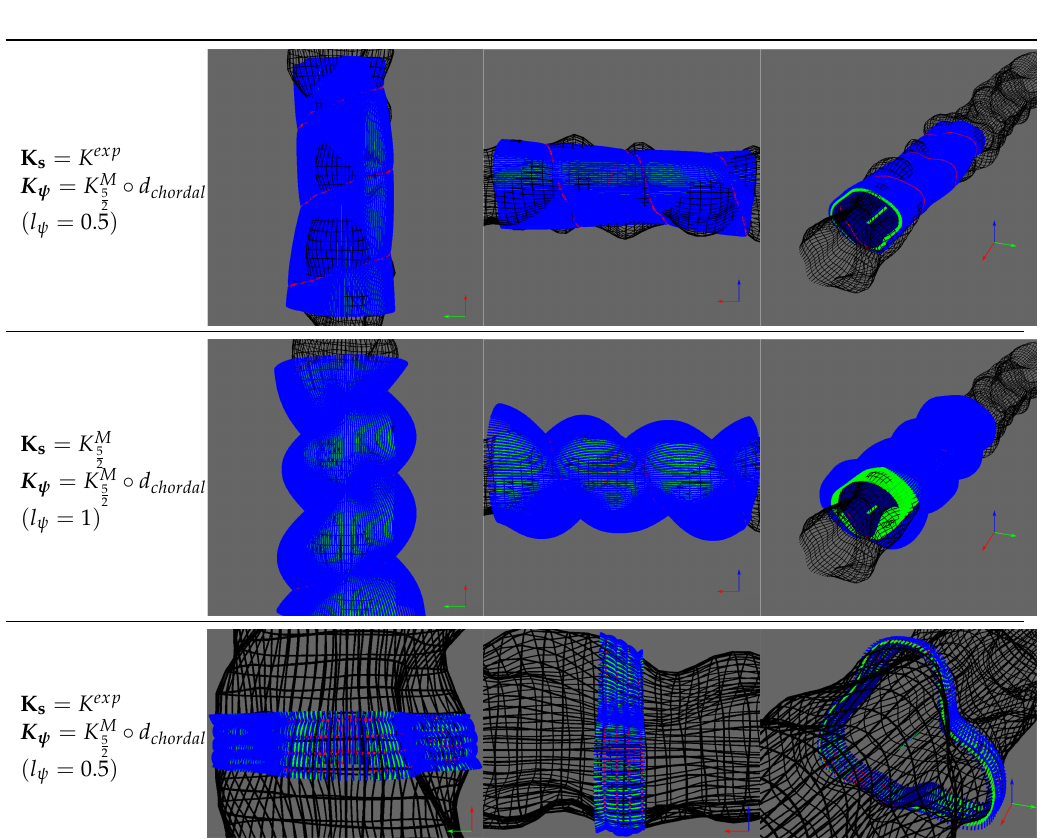
Figure 12. Some 3D views of the resulting GP regressions. The first two lines correspond to the sparse case and the last one to the dense case. The mean surface is represented in green and the lower/upper bound at +/ 3 σ is in dark blue/blue. Red points correspond to the simulated vertical − sonar